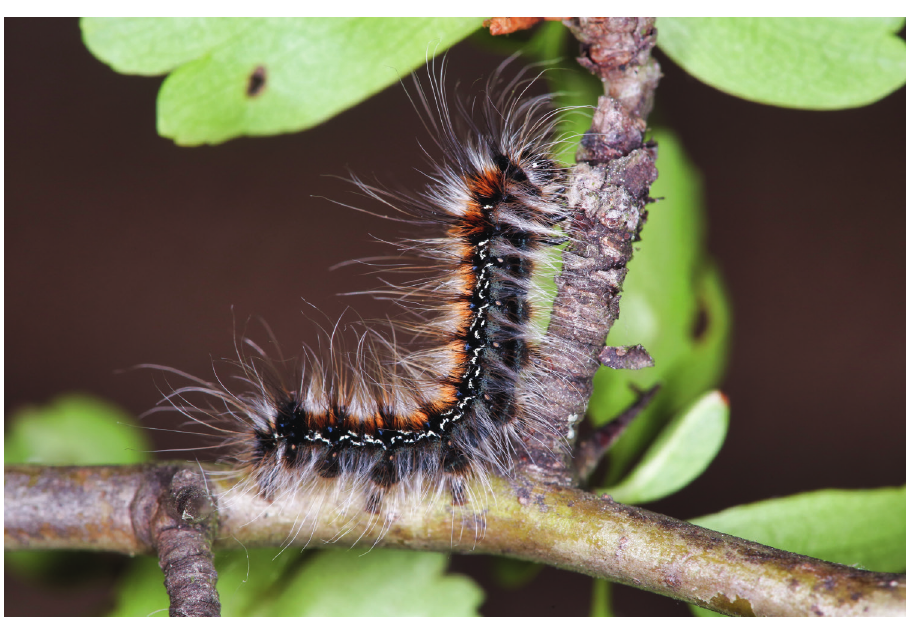
Figure 4. Eriogaster catax , larva.